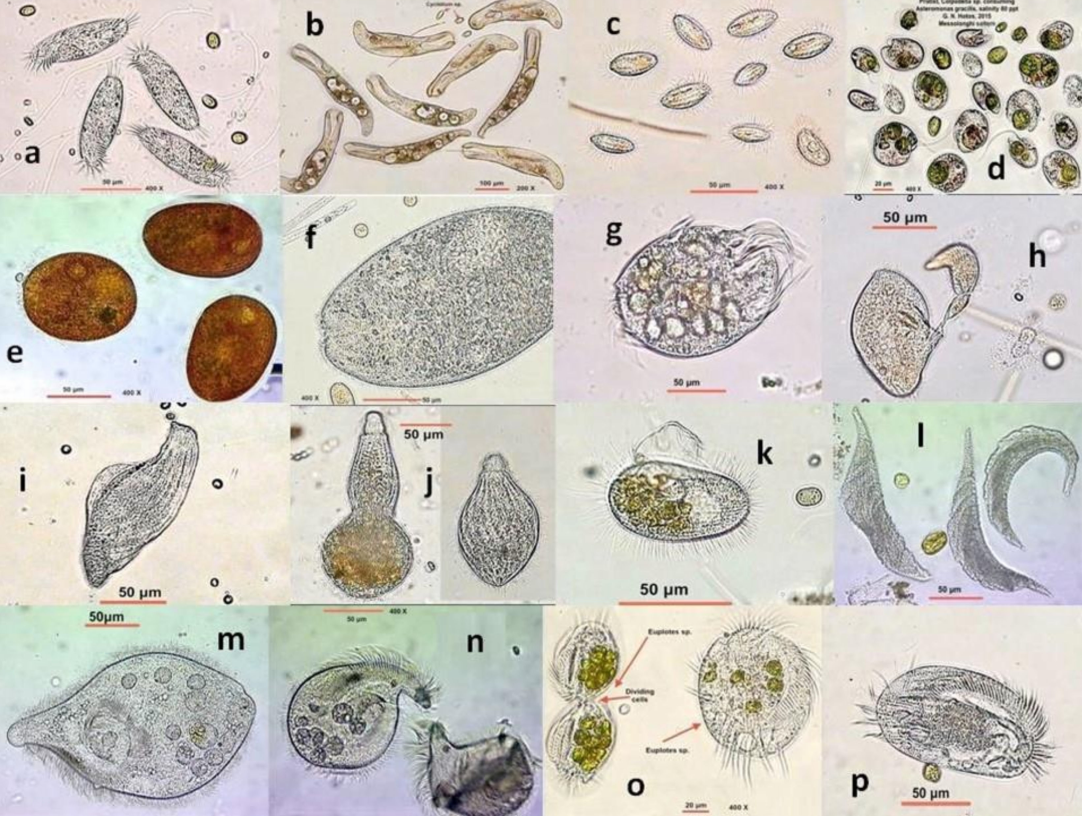
Figure 6. Representative ciliate Protozoa from a hypersaline pond of Messolonghi saltworks. ( a ) Litonotus sp.?; ( b ) Condylostoma sp.; ( c ) Cyclidium sp.; ( d ) Colpodella sp.; ( e ) Frontonia sp.; ( f ) Climacostomum sp.; ( g ) Uronychia sp.; ( h ) Holophrya sp. in budding reproduction; ( i ) Loxodes sp.; ( j ) Phialina sp.; ( k ) Pleuronema sp.; ( l ) Amphileptus sp.; ( m ) Fabrea salina at 90 ppt; ( n ) Fabrea salina at 170 ppt; ( o ) Euplotes sp. in division, full of Asteromonas cells (left); ( p ) Euplotes sp.